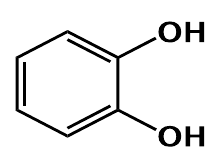
Figure 1. The chemical structure of catechol.